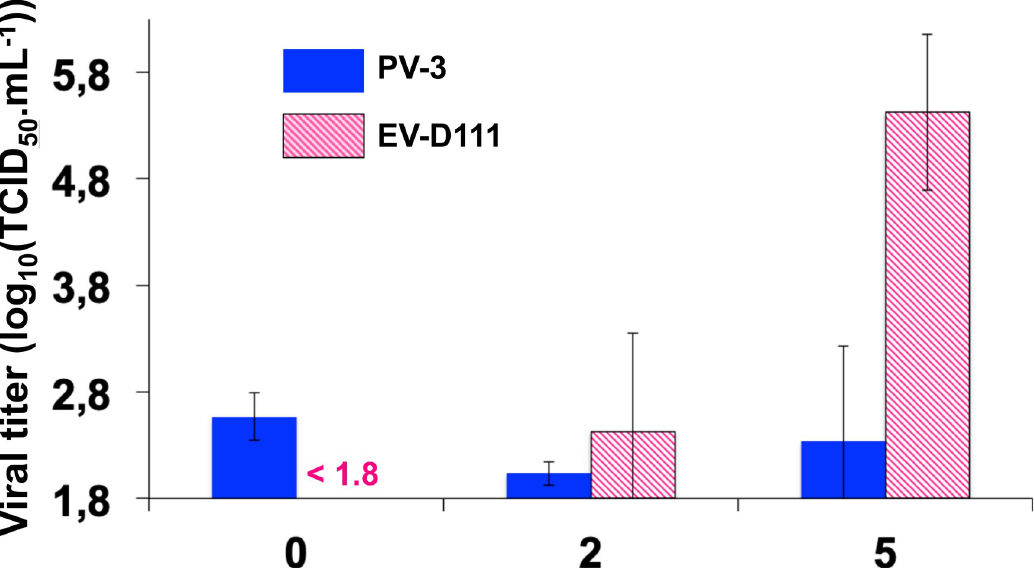
Fig 11. Replication kinetics assay in L cells. PV-3 strain Sabin and EV-D111 strain OUP-05-059 suspensions were used to inoculate L cell monolayers (1,000 TCID 50 and 100 TCID 50 per well, respectively). After three freeze-thaw cycles, well contents were harvested and clarified, and viruses were titrated on RD cells. Errors bars indicate the 95% confidence interval calculated on 4 wells. Titres lower than 101.8 TCID 50 .mL -1 cannot be measured.